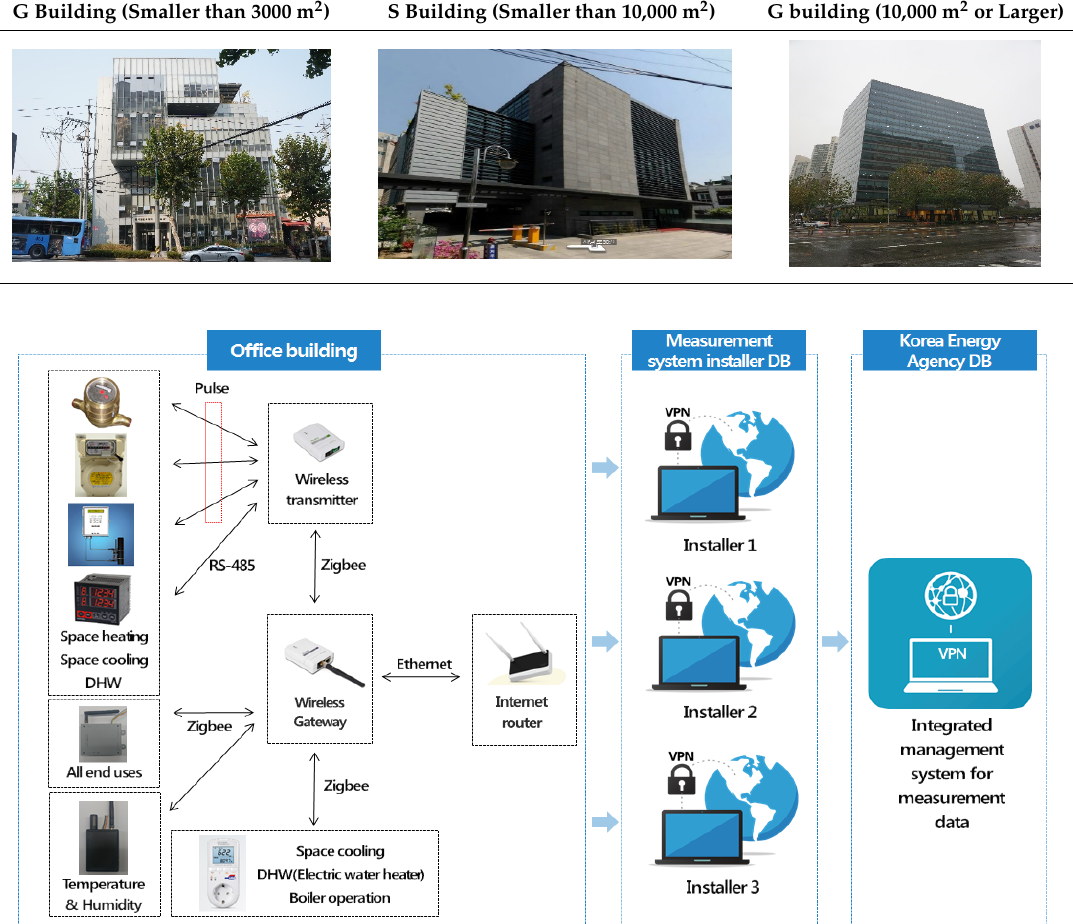
Figure 1. Measurement data collection system. Table 4. Photographs of sample office buildings .